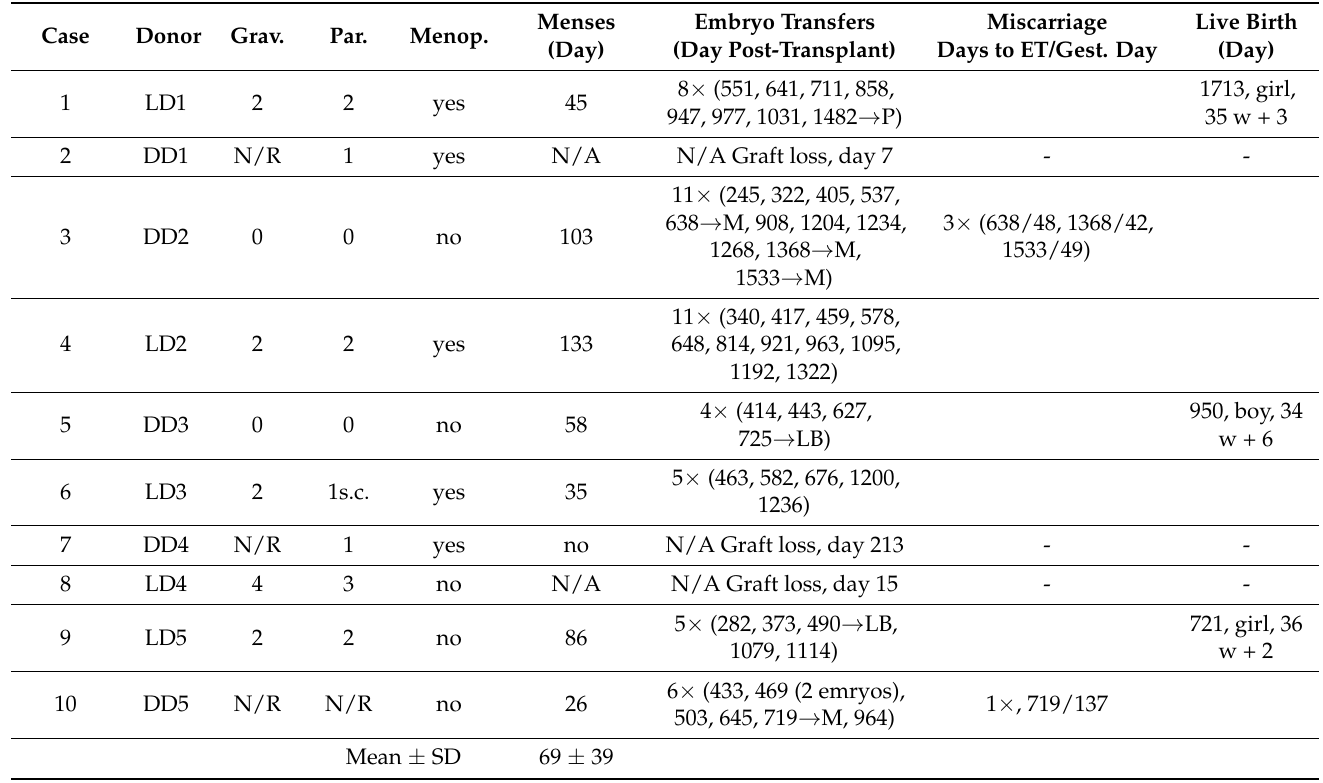
Table 7. Pregnancy outcomes of 10 consecutive uterus